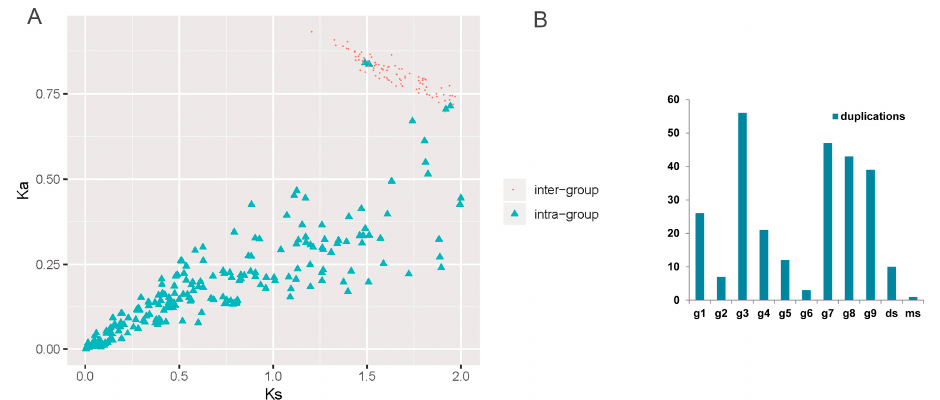
Figure 3. The selection pressure analysis of intra- and inter-duplicated SBP genes and the number of intra-group duplications in each group. ( A ) The X axis refers to the Ks value, and the Y axis refers to the Ka value. The inter-group duplications were marked with red dots, and the intra-group duplications were marked with green triangles. ( B ) A bar chart of the intra-group duplications in each group.